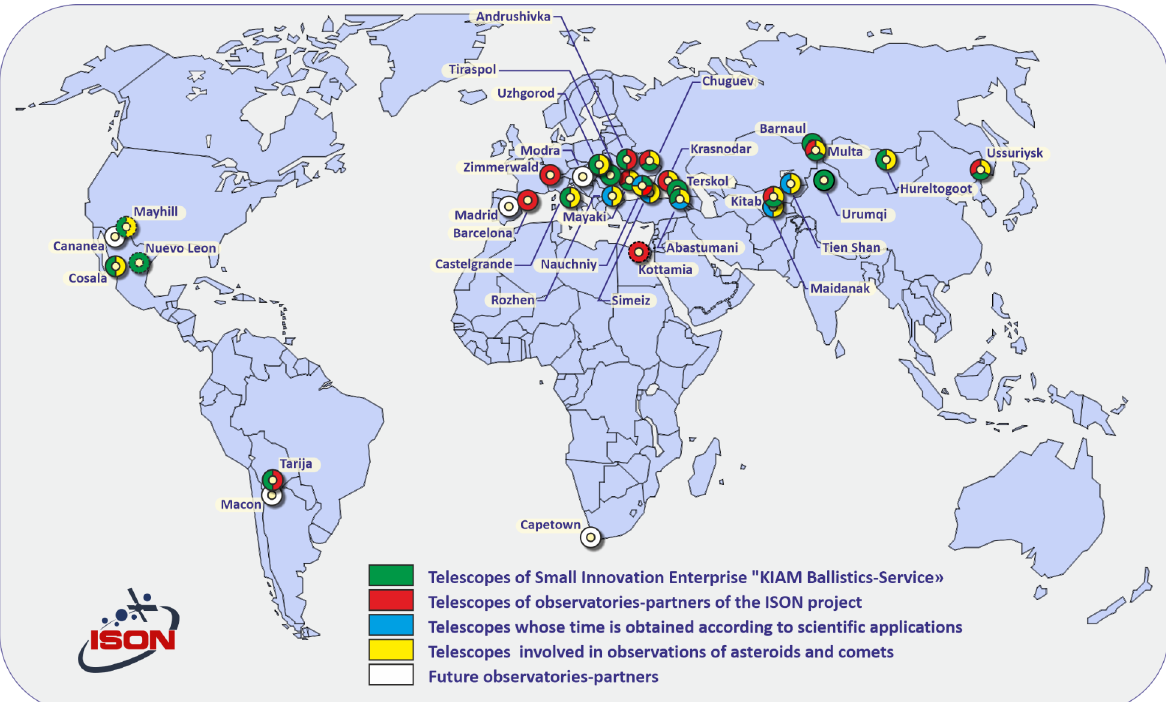
Figure 1. Map of the ISON observatories. Here geographical location and names of observatories are presented. Various colors indicate the status of participation of the observatory in the